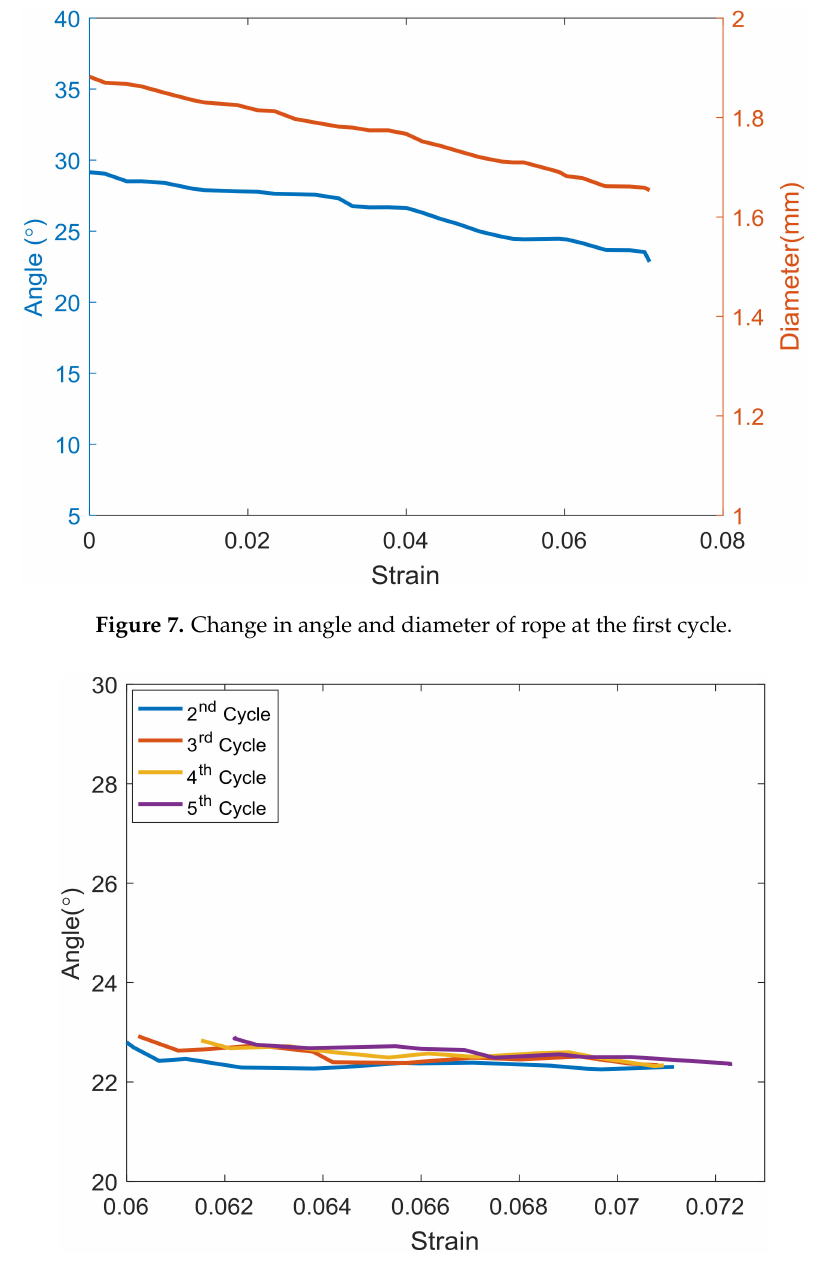
Figure 8. Change in angle of rope for the second to fifth